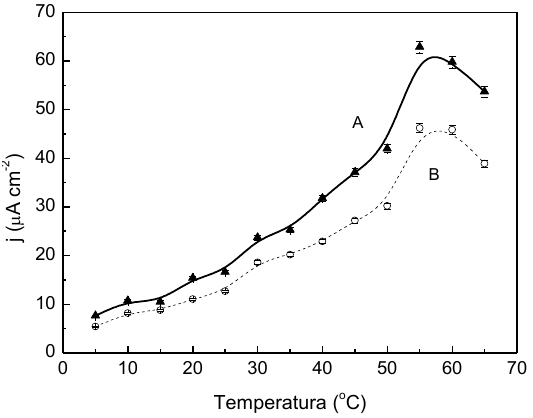
Figure 6. Responses of current for PPy/Tyr films prepared in pyrrole, phosphate buffer, and catechol at different temperatures without ( A ) and with ( B ) benzoic acid.